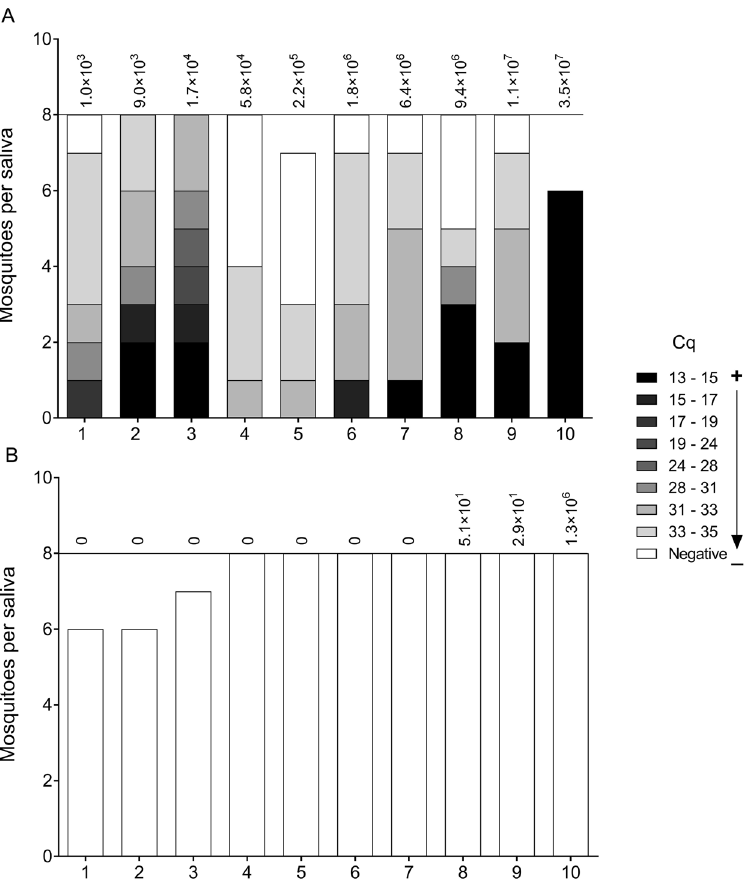
Figure 4. Injection of saliva into naive mosquitoes. Saliva was collected from Br and w Mel mosquitoes infected with fresh virus at 7 dpi. All of the Br saliva samples ( A ) were infectious, but no infections were observed when saliva samples originated from w Mel mosquitoes ( B ). The color gradient indicates the infection level and varies according to the quantification cycle (Cq). The most infected are shown in black and there is a color gradient toward the uninfected in white. Values at the top of the graphs show the MAYV copy numbers in the head and thorax of the mosquito that the saliva was collected from (as determined by